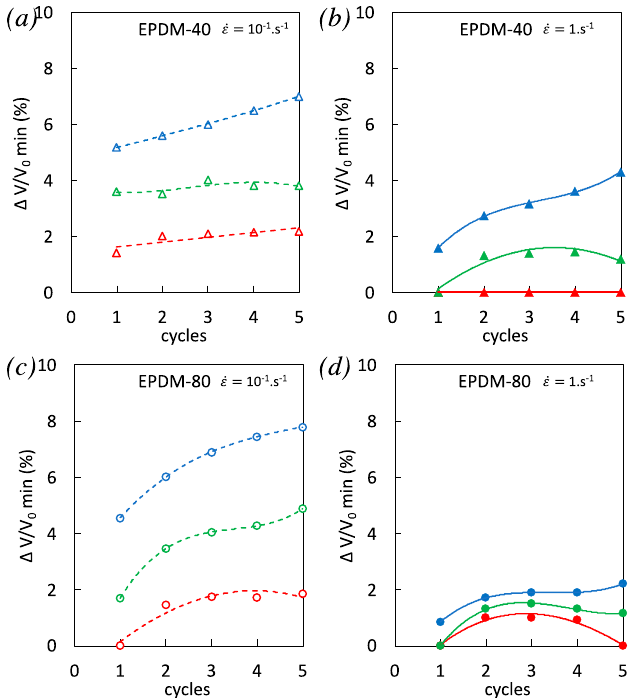
Figure 9. Minimum volumetric strain reached during multiple cyclic loadings performed at three different stretching ratios λ 1 = 2 (in red), λ 2 = 2.9 (in green), and λ 3 = 3.7 (in blue), and for the strain rates 10 − 1 s − 1 (unfilled symbols) and 1 s − 1 (filled symbols) for EPDM-40 ( a – b ) and EPDM-80 ( c – d ).